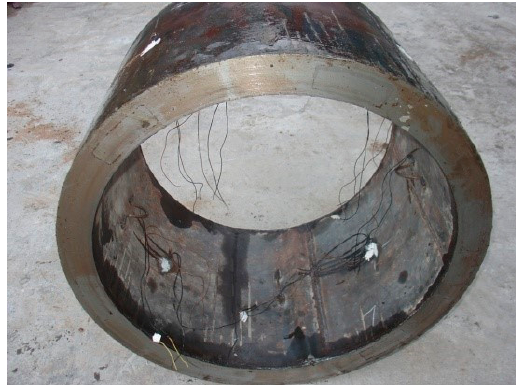
Figure 3. Well-processed shaft lining model. Figure 4. Loading device for simulation testing.